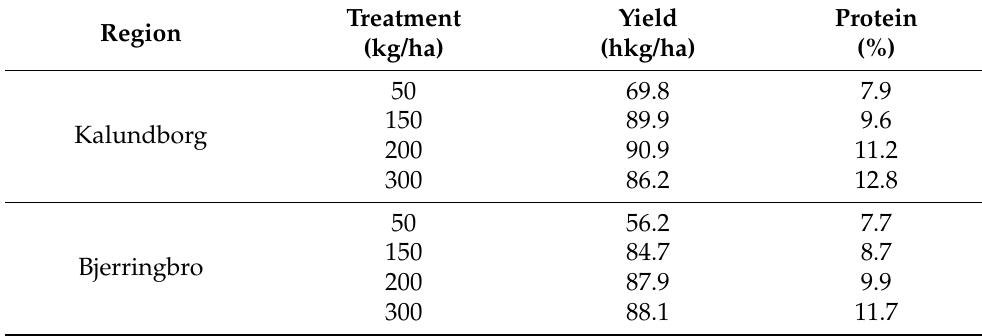
Table 2. Initial experimental measurements with the mean amounts for both regions. Treatment Yield Region